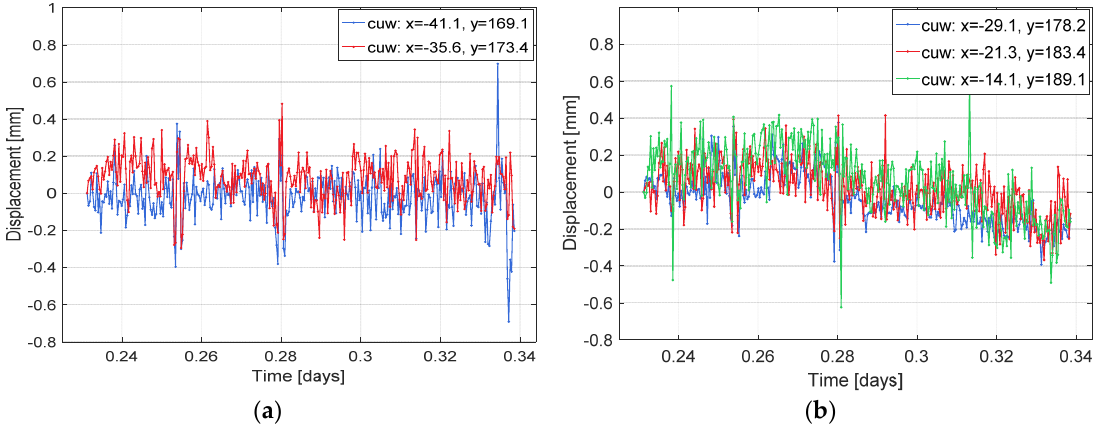
Figure 7. LOS displacement after atmospheric correction of the five representative PS points. ( a ) indicates points ( − 41.1, 169.1) and ( − 35.6, 173.4); ( b ) indicates points ( − 29.1, 178.2), ( − 21.3, 183.4) and ( − 14.1, 189.1).